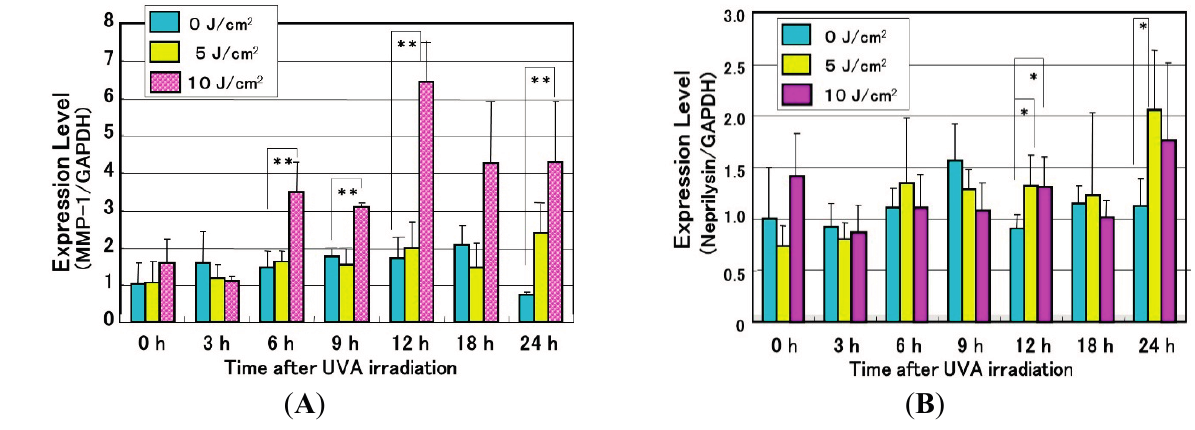
Figure 9. Effects of UVA radiation on mRNA levels of neprilysin (NEP) ( A ) and MMP-1 ( B ) in human dermal fibroblasts as revealed by real-time RT-PCR analysis. n = 5 * p < 0.05; ** p < 0.01.